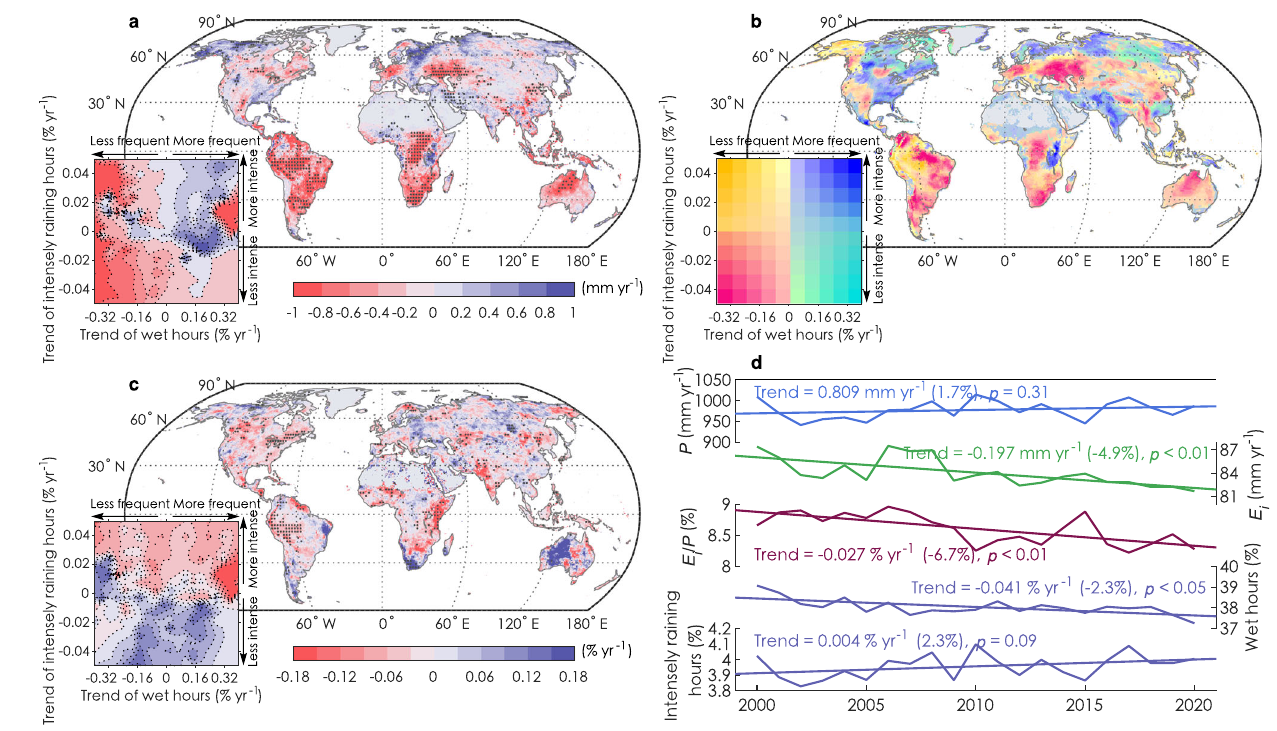
Fig. 5 | Temporal changes of rainfall interception loss ( E i ) for 2000 – 2020 controlled by rainfall ( P ) characteristics. Spatial patterns of the linear trend in annual E i ( a ),rainfallfrequencyand intensity( b )and theratioof E i to P ( E i / P )( c ),all calculated for the 2000 – 2020 period. Stipples show statistically signi fi cant ( p <0.05) trends. The inset plots at the lower left corners of a and c show the distribution of the value in the space of rainfall frequency and intensity changes.